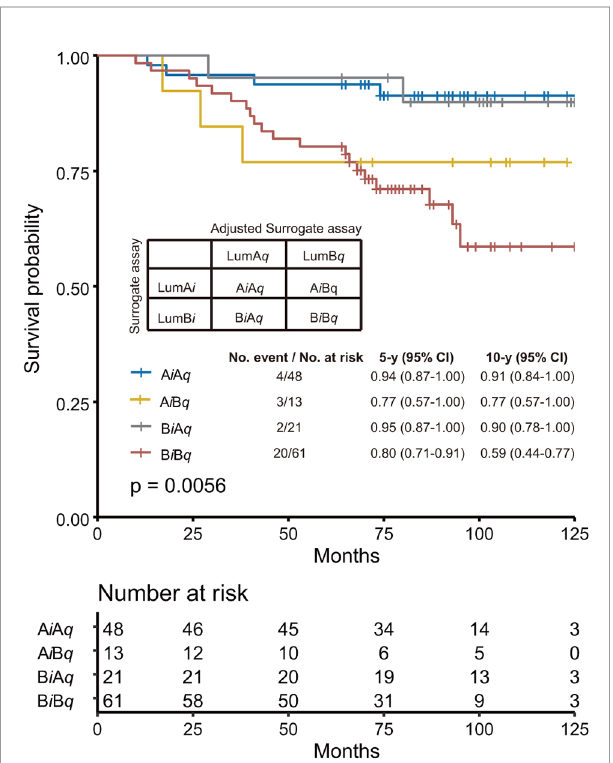
FIGURE 4 | Comparison of the performance of surrogate assay with that of adjusted surrogate assay. The specimens were further subgrouped into A i A q and B i B q subgroups, representing specimens assigned as Luminal A-like subtype and Luminal B-like subtype by both assays; A i B q , representing specimens assigned as Luminal A subtype by surrogate assay, but as Luminal B subtype by adjusted surrogate assay; and B i A q , representing specimens assigned as Luminal B-like subtype by surrogate assay, but as Luminal A-like subtype by adjusted surrogate assay. The overall survival analysis was performed with these four subgroups using Kaplan – Meier survival analysis, with survival probability for each individual subgroup provided in the fi gure. The p -value was calculated with Log rank